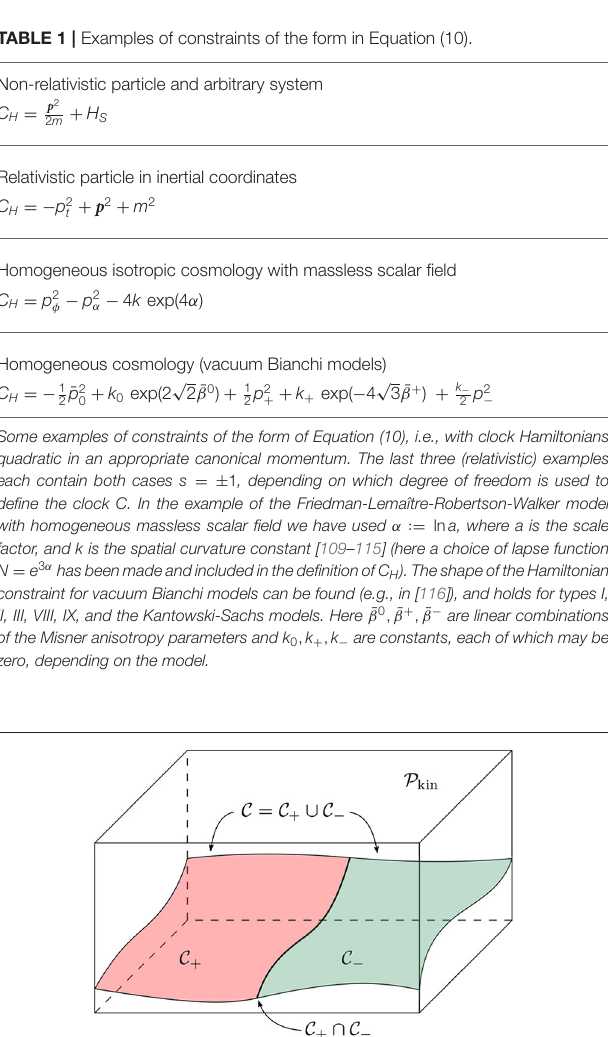
(red) and C (green) defined by + − C is characterized + ∩ −